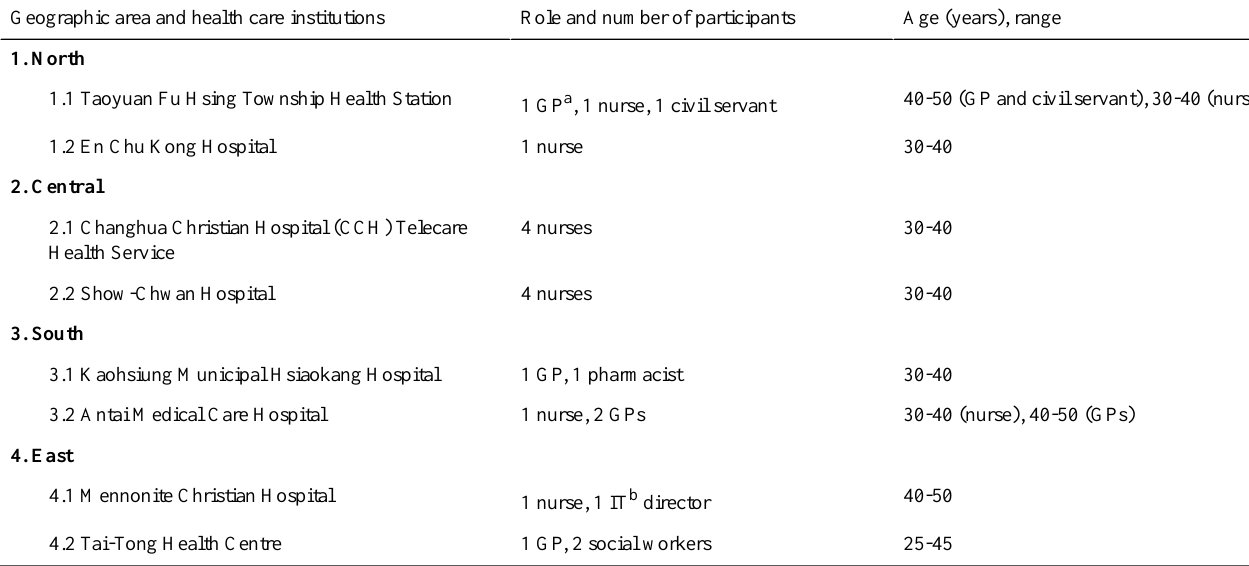
Table 1. Allied health professionals participating in the study.